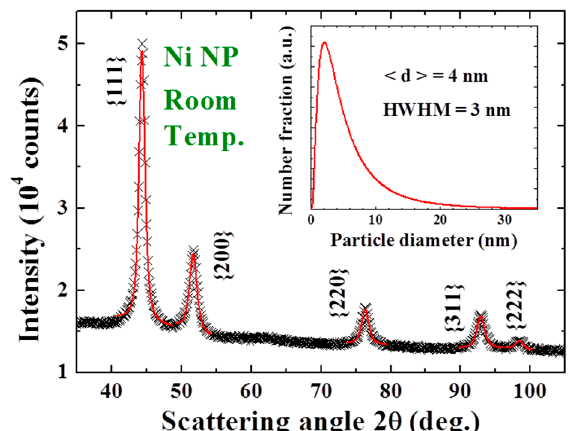
Figure 13. X-ray diffraction pattern of the Ni nanoparticle assembly taken at room temperature, revealing a series of diffraction peaks associated with face-centered cubic Ni. The solid curves indicate the calculated profiles for 4 nm Ni with the size distribution shown in the inset.